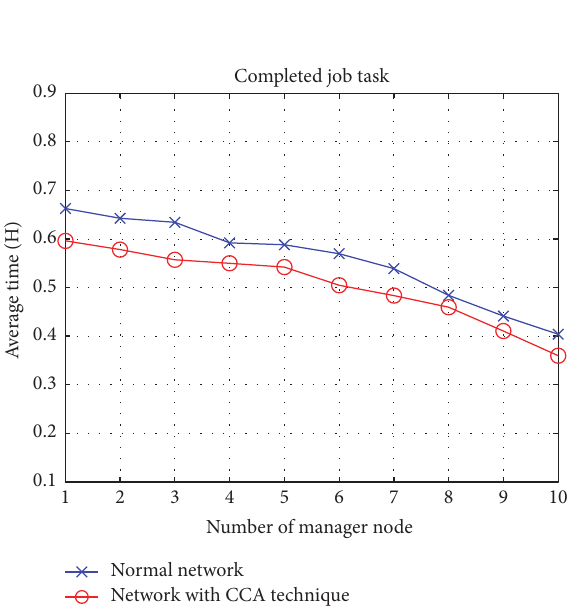
Figure 8: Utilization.